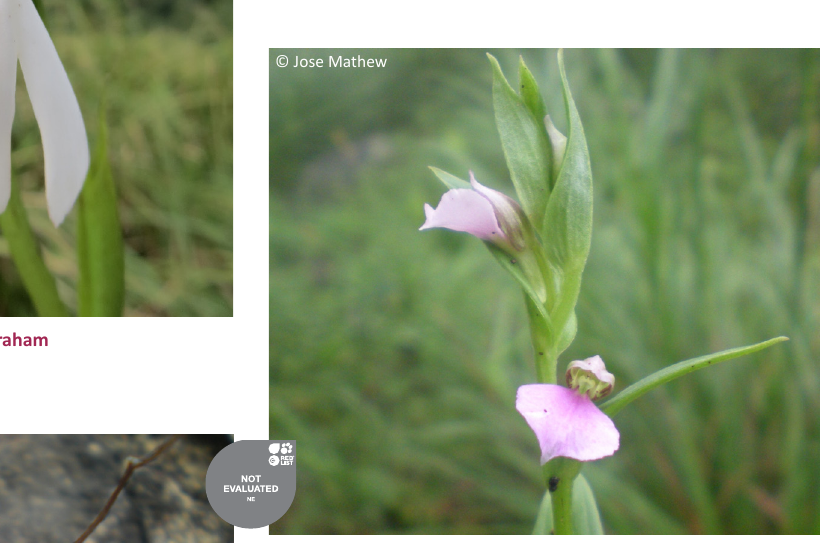
Image 13. Brachycorythis iantha (Wight)